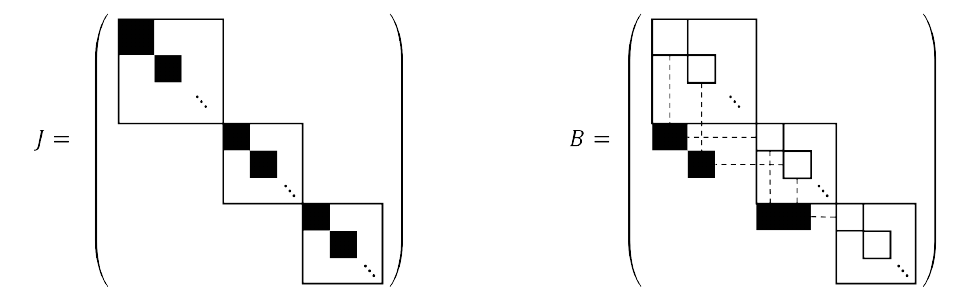
Figure 6: The matrix representation of the CCA